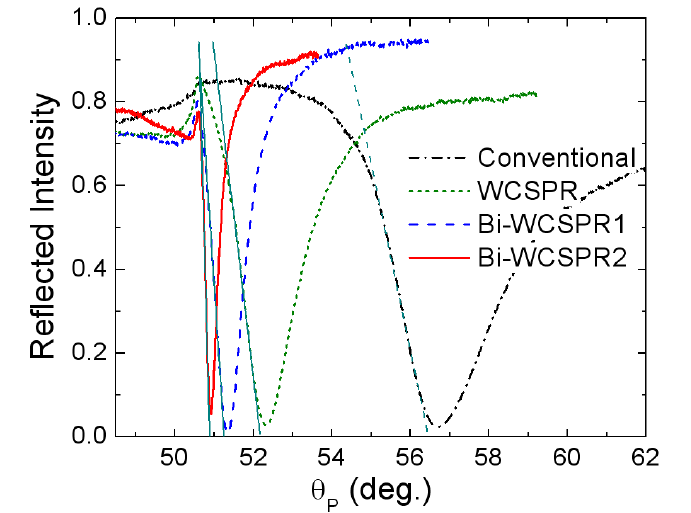
Figure 3. Measured SPR angular reflectivity curves for the model configurations fabricated with the geometrical parameters given in Figure